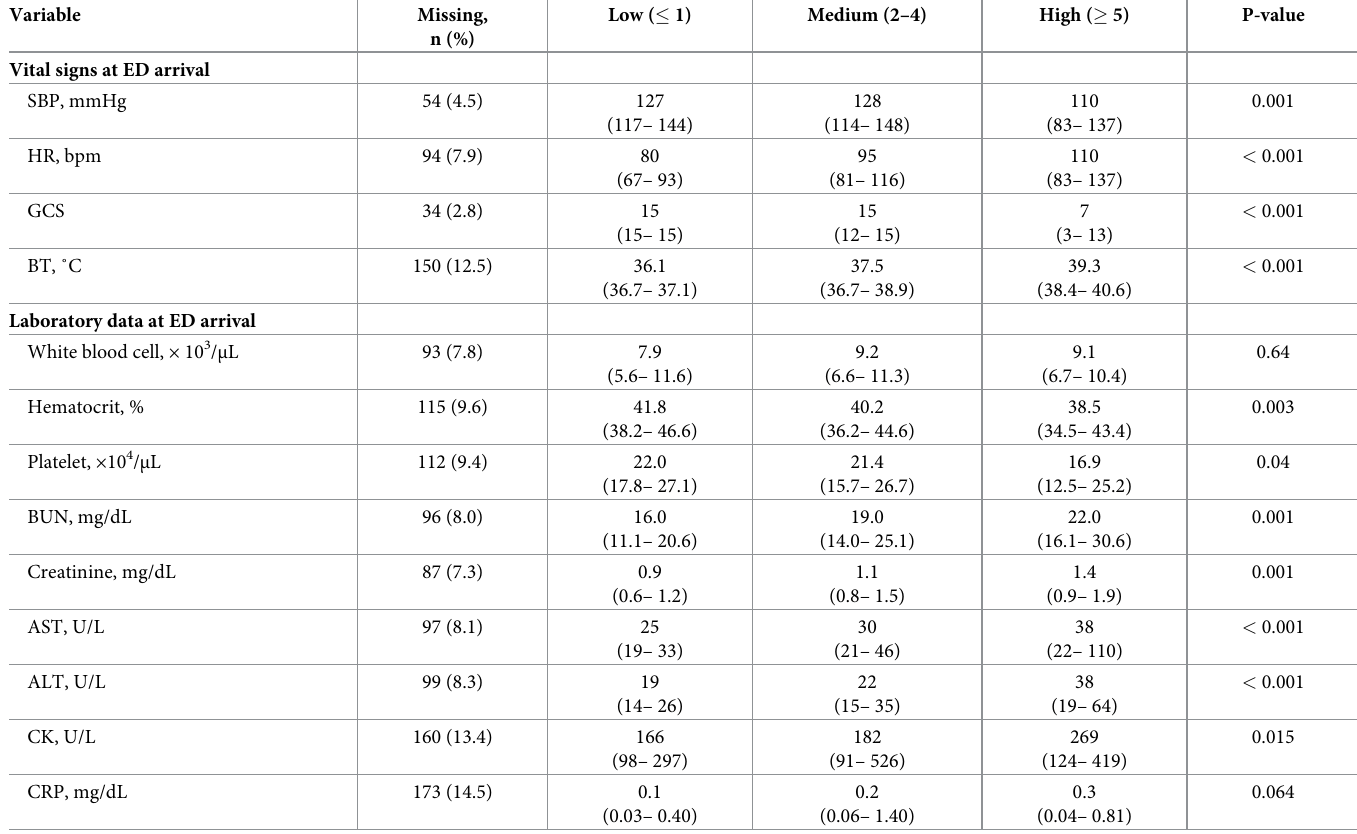
Table 2. Patients’ demographics and laboratory data on ED arrival according to J-ERATO score in the validation